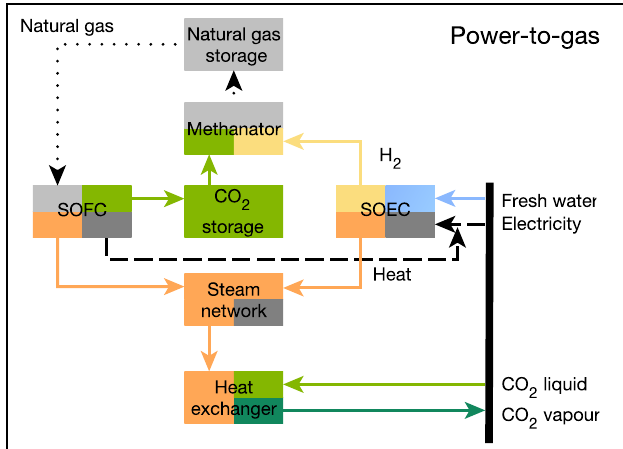
Figure 2. P2G schematic